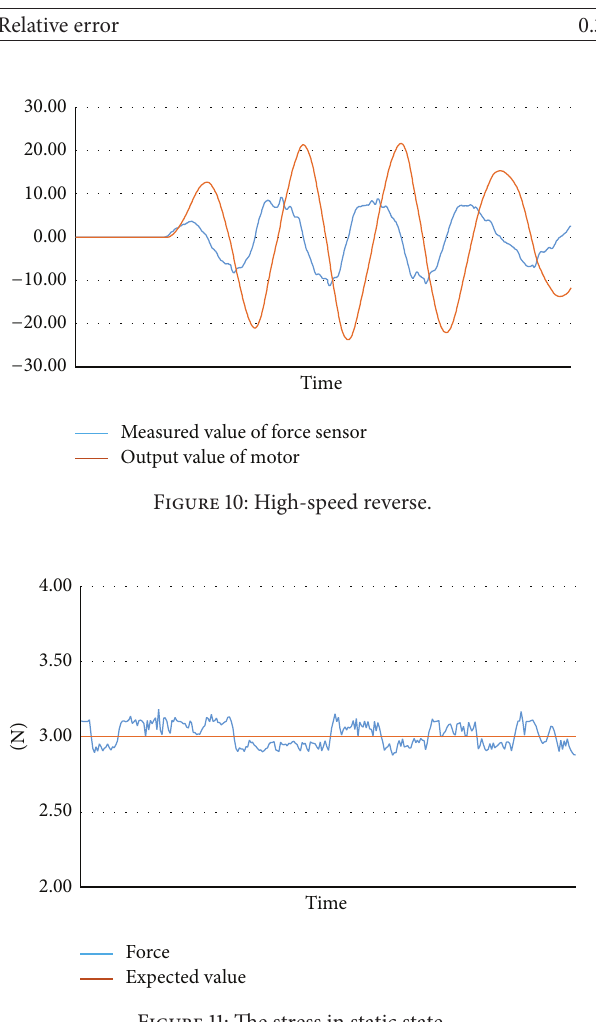
Figure 11: The stress in static state.